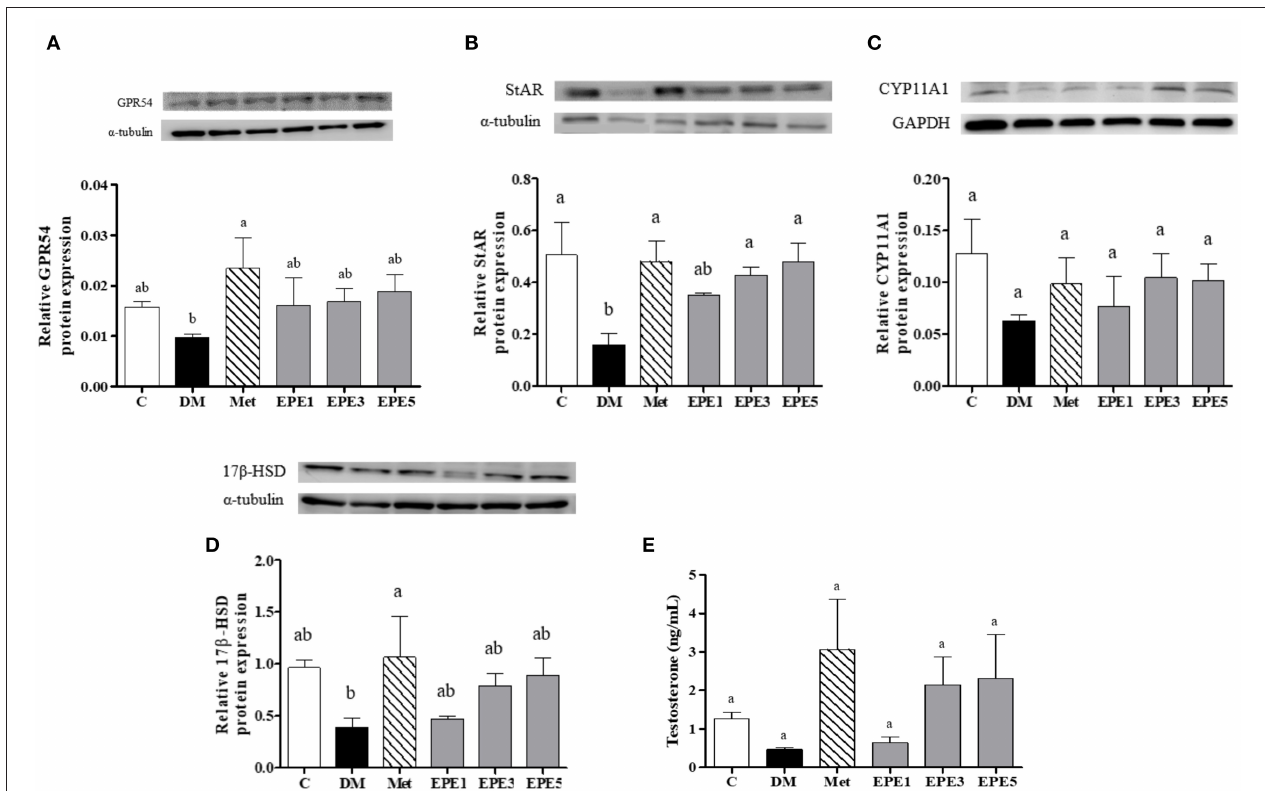
FIGURE 7 | Protein expression of (A) GPR54 (Kiss-1 receptor) in hypothalamus, (B–D) testosterone synthesis enzymes in testis, and (E) plasma testosterone level in diabetic rats after 4 weeks of treatment. Data are shown as the mean ± SEM ( n = 6). The values with different superscript letters (a,b) represent significant differences ( p < 0.05) as analyzed by Duncan’s multiple range test. C, control; DM, diabetes mellitus; Met, metformin; EPE, Echinacea purpurea ethanol